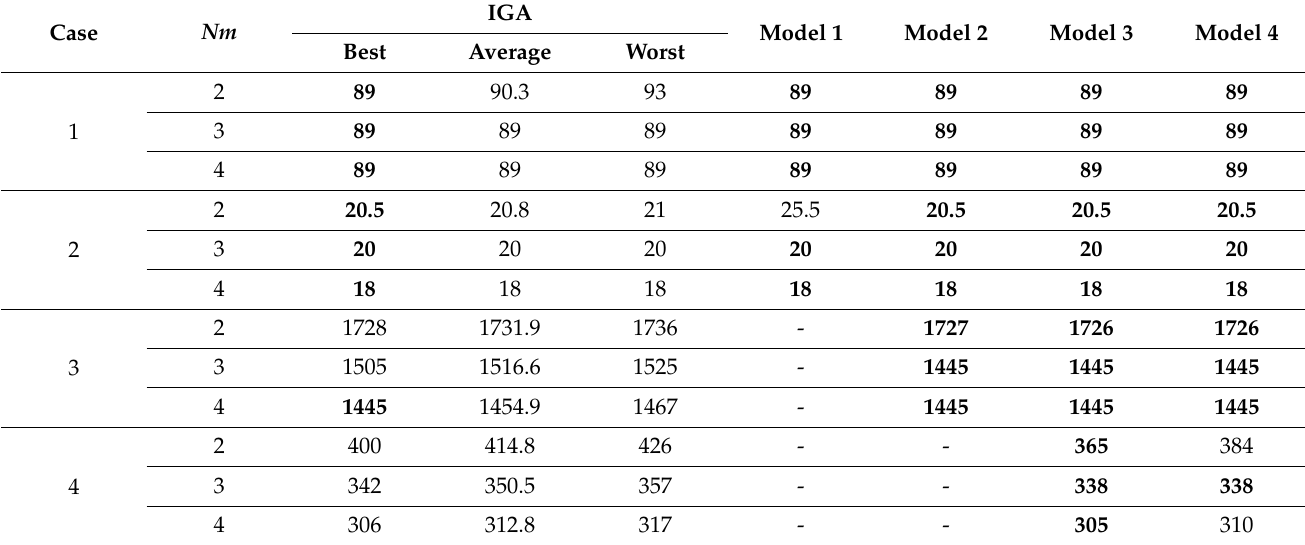
Table 5. Computational results of our MILP models and the